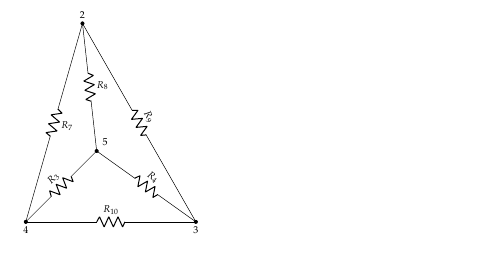
Figure 5. A modified multi-connected resistive grid configuration.